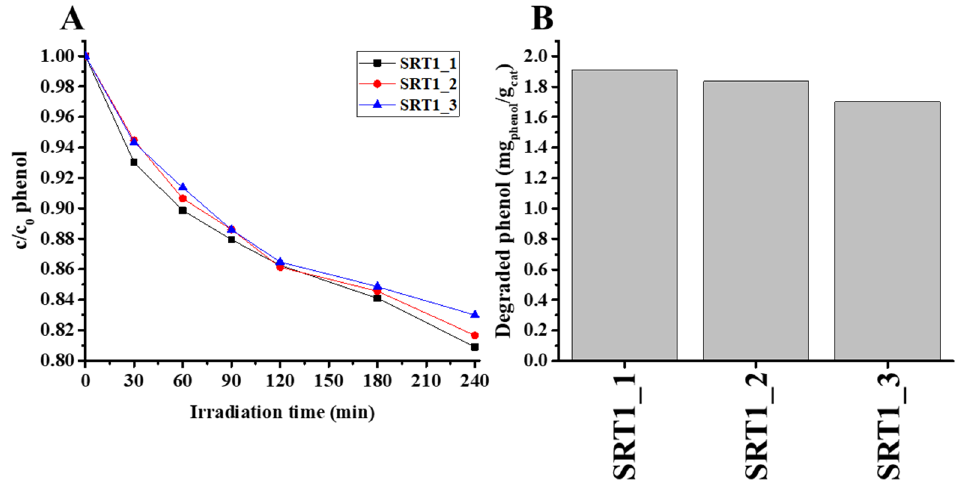
Figure 6. Photocatalytic activity of the SRT1 photocatalysts through 3 rounds, run of decay curves ( A ) and the degraded specific amount of phenol (mg phenol /g cat ) ( B ).